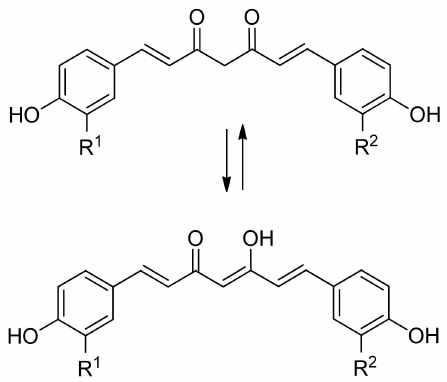
Figure 9. Structure and keto–enol tautomerism of curcumin (R 1 = R 2 = OMe), desmethoxycurcumin (R 1 = OMe, R 2 = H), and bisdesmethoxycurcumin (R 1 = R 2 =